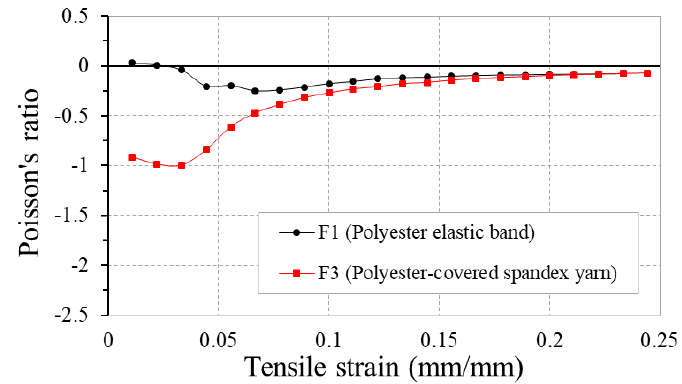
Figure 12. PR-tensile strain curves of fabrics F1 and F3 made with different types of weft yarn.